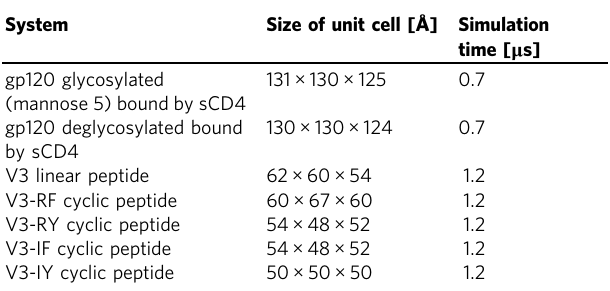
Table 1 List of performed molecular dynamics